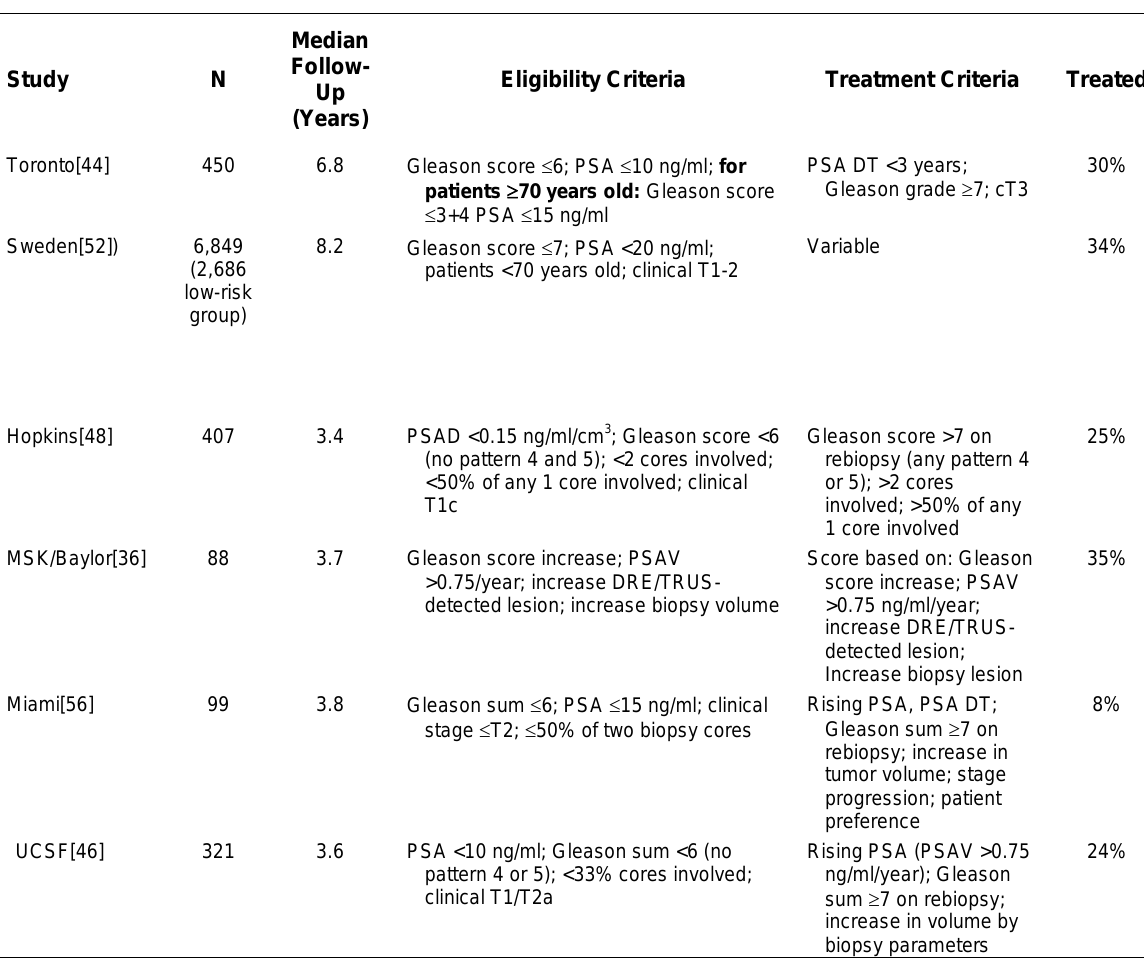
Active Surveillance Cohorts